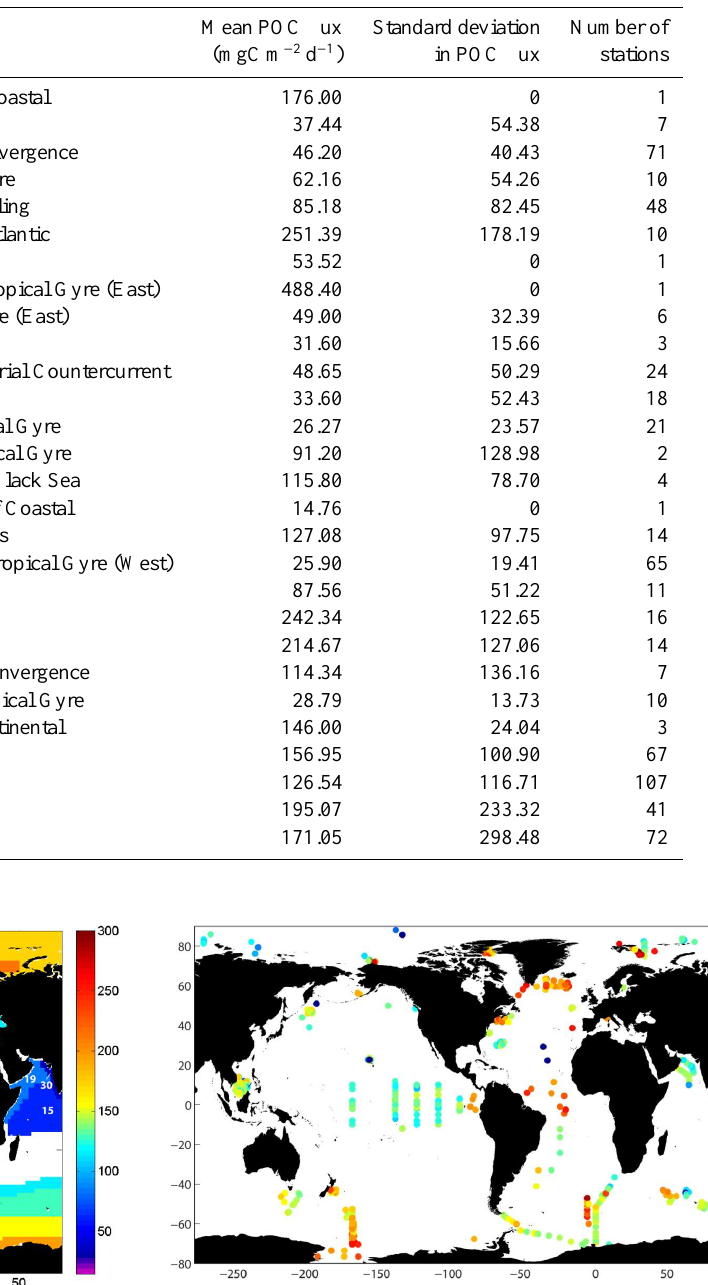
Table 2. Mean POC flux (mgm − 2 d − 1 ) per Longhurst province (Longhurst, 2006).